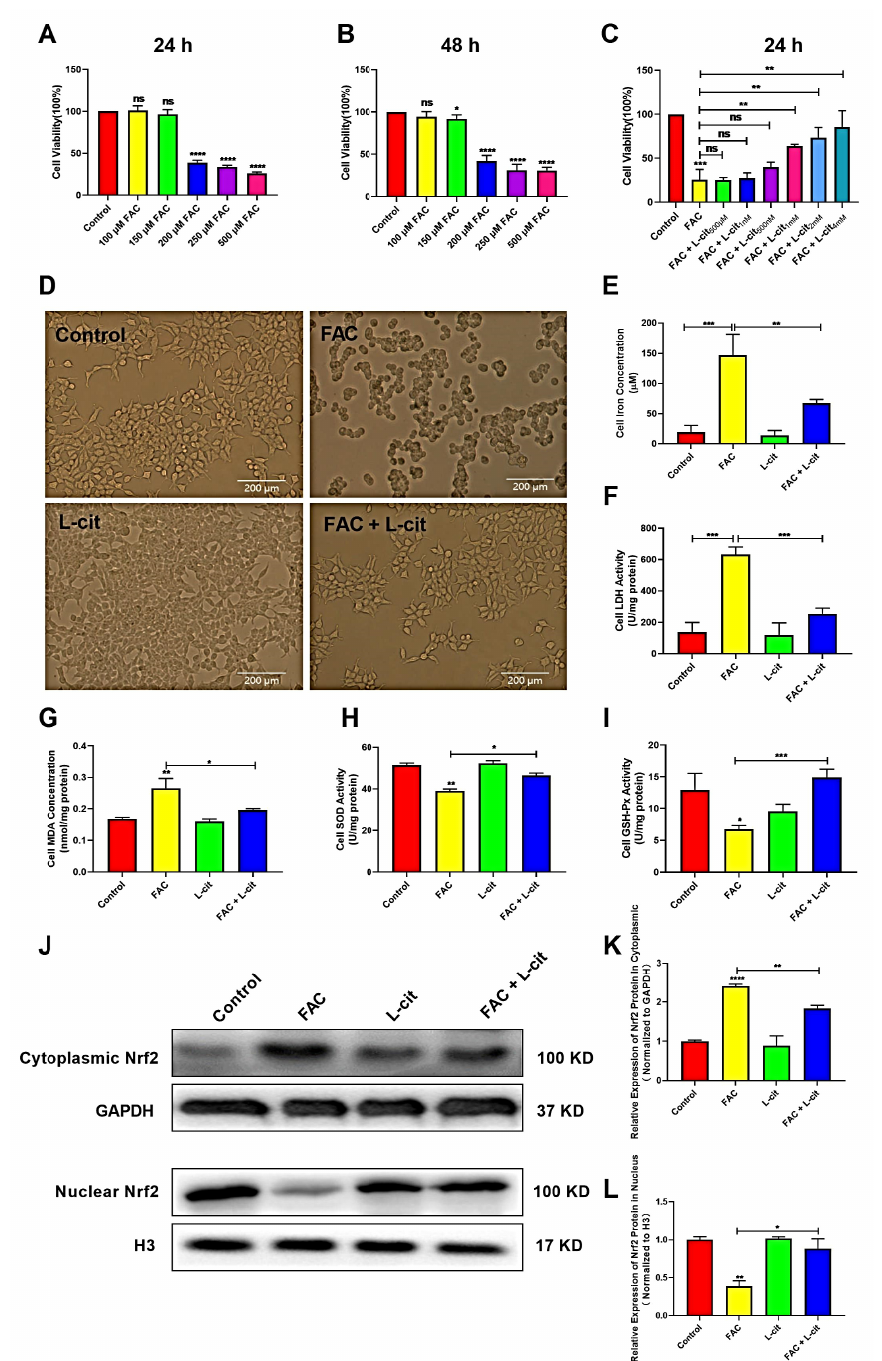
Figure 5. L-cit improves the cell viability, antioxidant capacity, and Nrf2 activation in the mTEC1 cells. The mTEC1cells were exposed to 100, 150, 200, 250, and 500 µ M FAC for 24h or 48 h. Cell viability, iron concentration, LDH activity, antioxidant capacity, and Nrf2 expression were investi- gated. ( A ) Cell viability at 24 h following FAC treatment. ( B ) Cell viability at 48 h following FAC treatment. ( C ) Cell viability at 24 h following 200 µ M FAC cotreated with different dosage of L- cit. ( D ) Cell morphology and viability treated with 2 mM L-cit, followed by 200 µ M FAC for 24 h. ( E ) Iron concentration. ( F ) LDH activity. ( G ) MDA concentration. ( H ) SOD activity. ( I ) GSH-Px activity. ( J , K ) Immunoblot analyses of Nrf2 in cytoplasm. GAPDH was used as the loading control. ( J , L ) Immunoblot analyses of Nrf2 in nucleus. H3 (Histone H3) was used as the loading control. Val- ues represent mean ± SEM. of three independent experiments. Significant differences are represented by * p < 0.05, ** p < 0.01, *** p < 0.001, **** p < 0.0001, ns (not